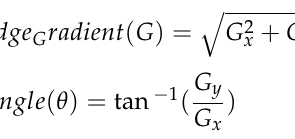
Figure 7. The mathematics behind the operation of Canny Edge Detection is shown in the equa- tions above.